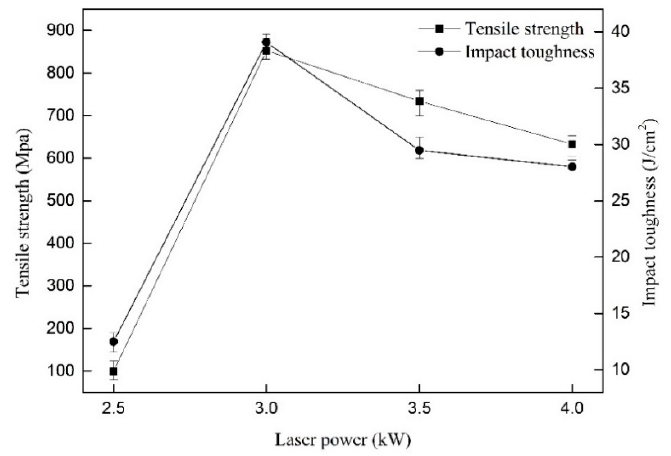
Figure 13. The influence of laser powers on tensile strength and impact toughness. Table 4. Welding test